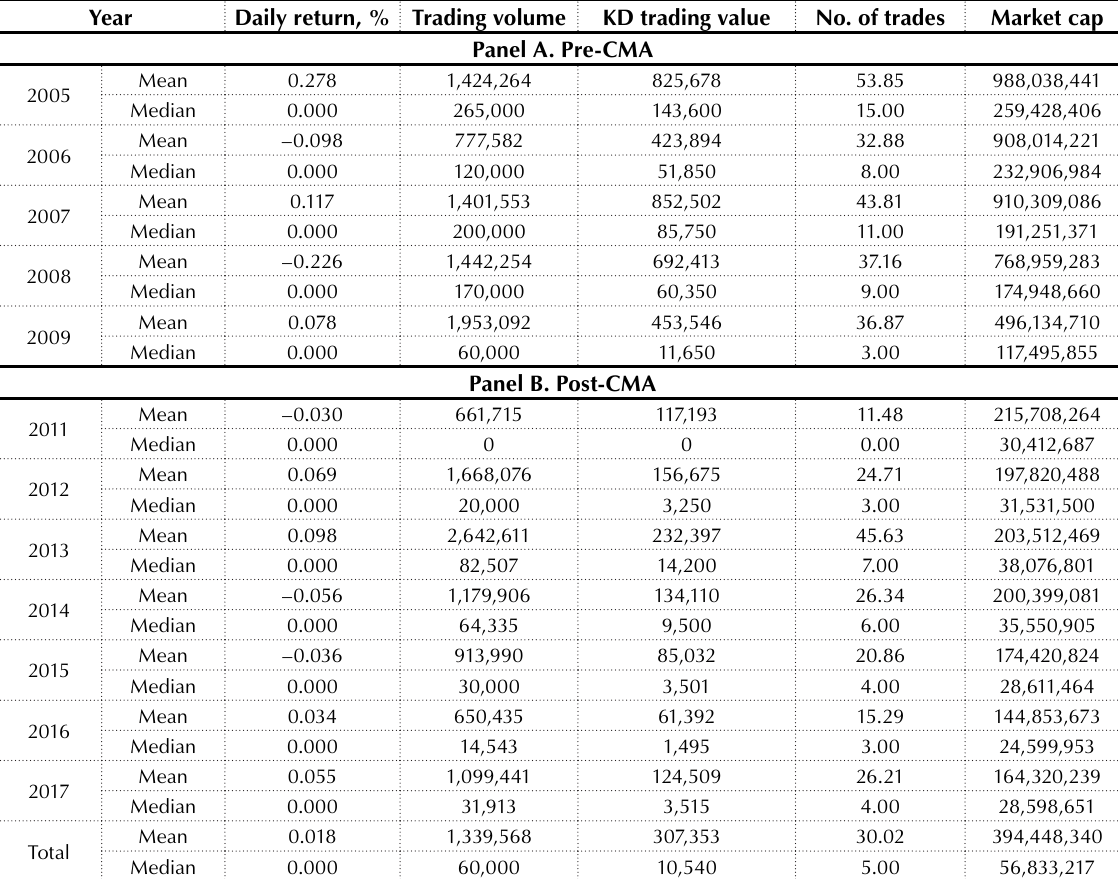
Table 1. Descriptive statistics for the main variables in pre-post CMA Law Year Daily return, % Trading volume KD trading value Panel A.